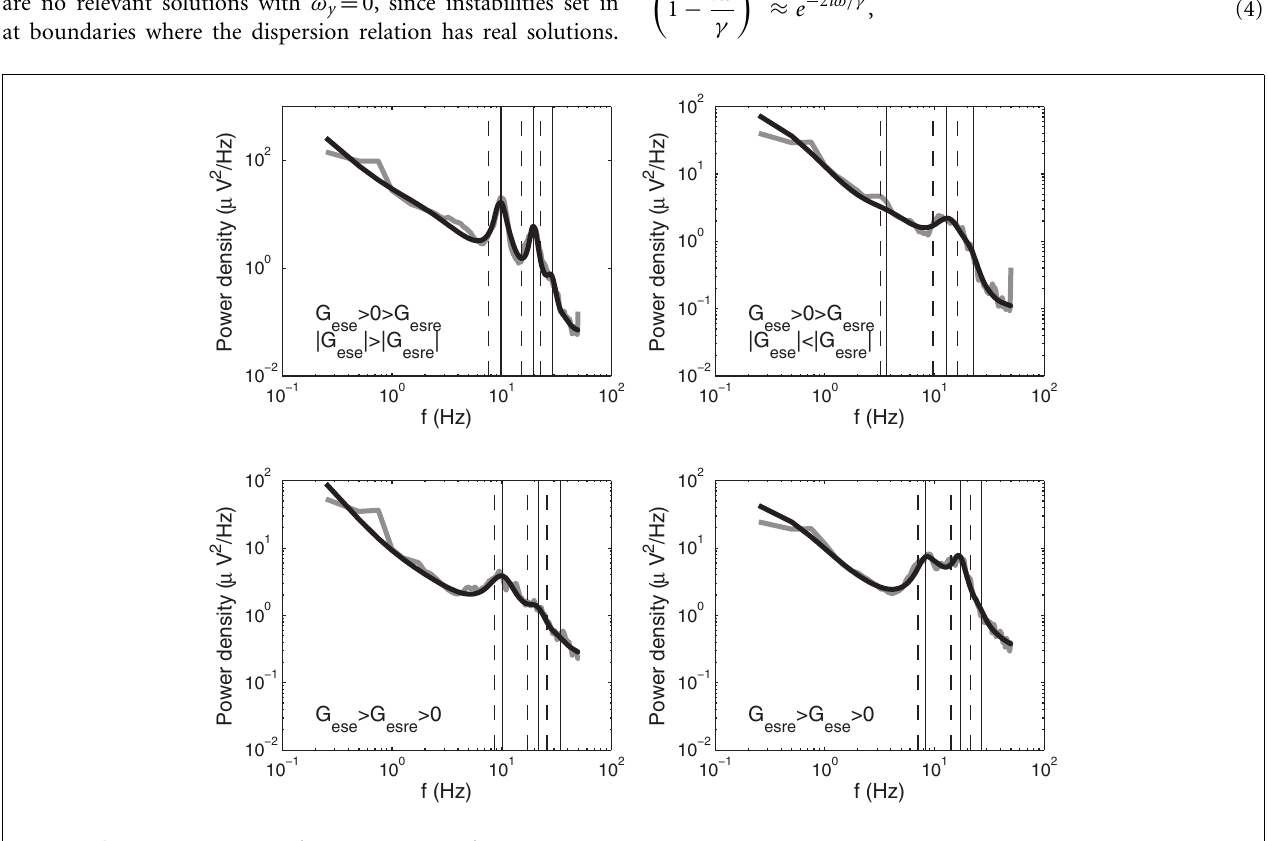
FIGURE 3 | Initial approximations (dashed vertical lines) and precise estimates (solid vertical lines) of peak frequencies in model spectra for four subjects with different values of their corticothalamic loop gains G ese and G esre . For subjects with G ese > 0 > G esre and | G ese | < | G esre |, we